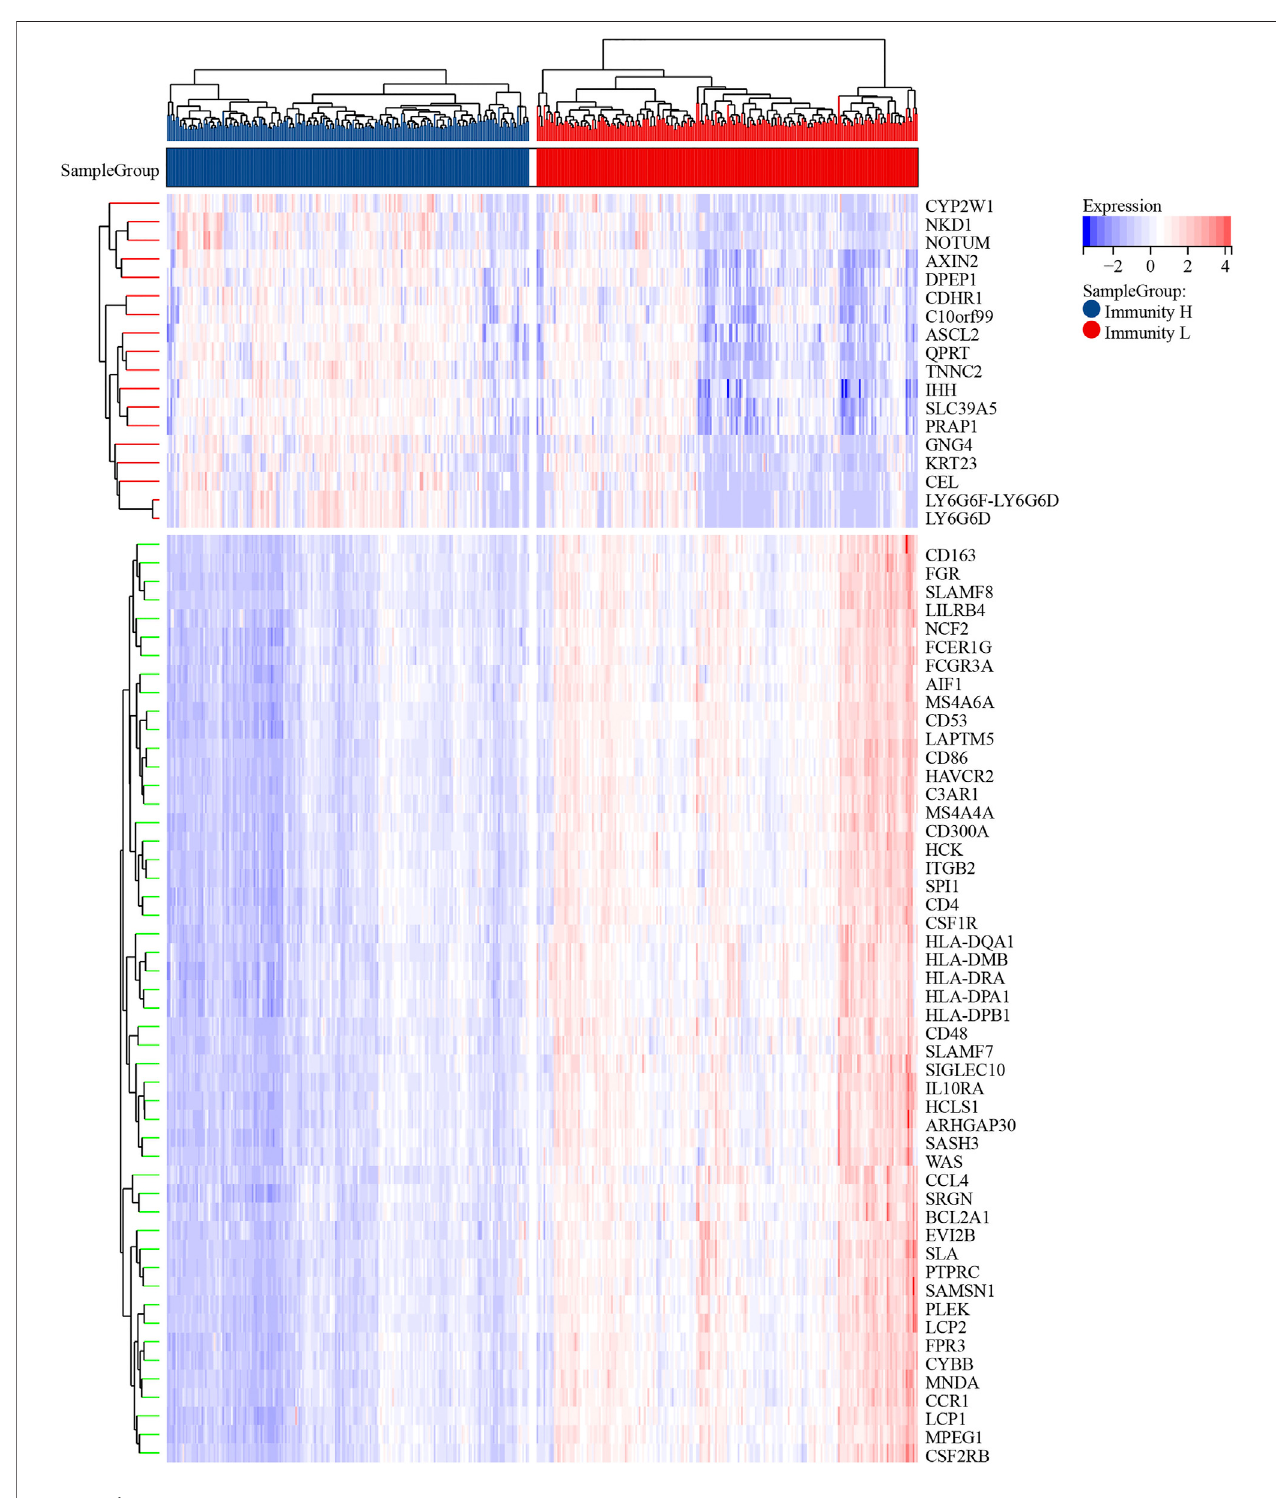
Frontiers in Bioengineering and Biotechnology | www.frontiersin.org February 2022 | Volume 10 | Article 820092